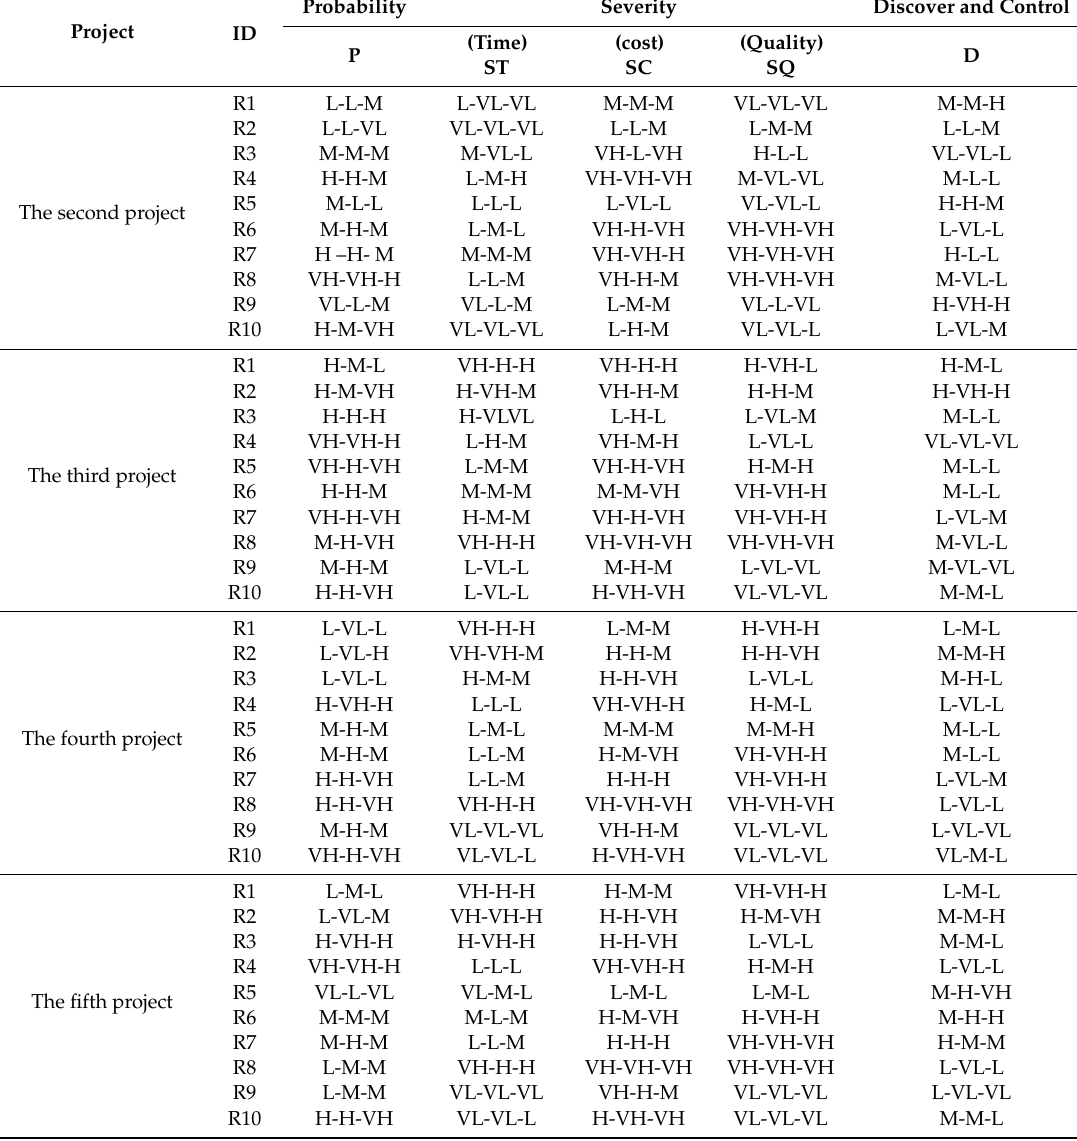
Table A1. Comments from three groups of experts for each of the